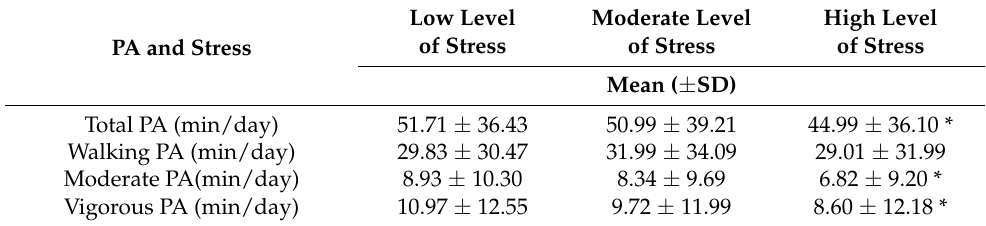
Table 4. Time of physical activity according to the level of stress in the study population ( n = 1956).